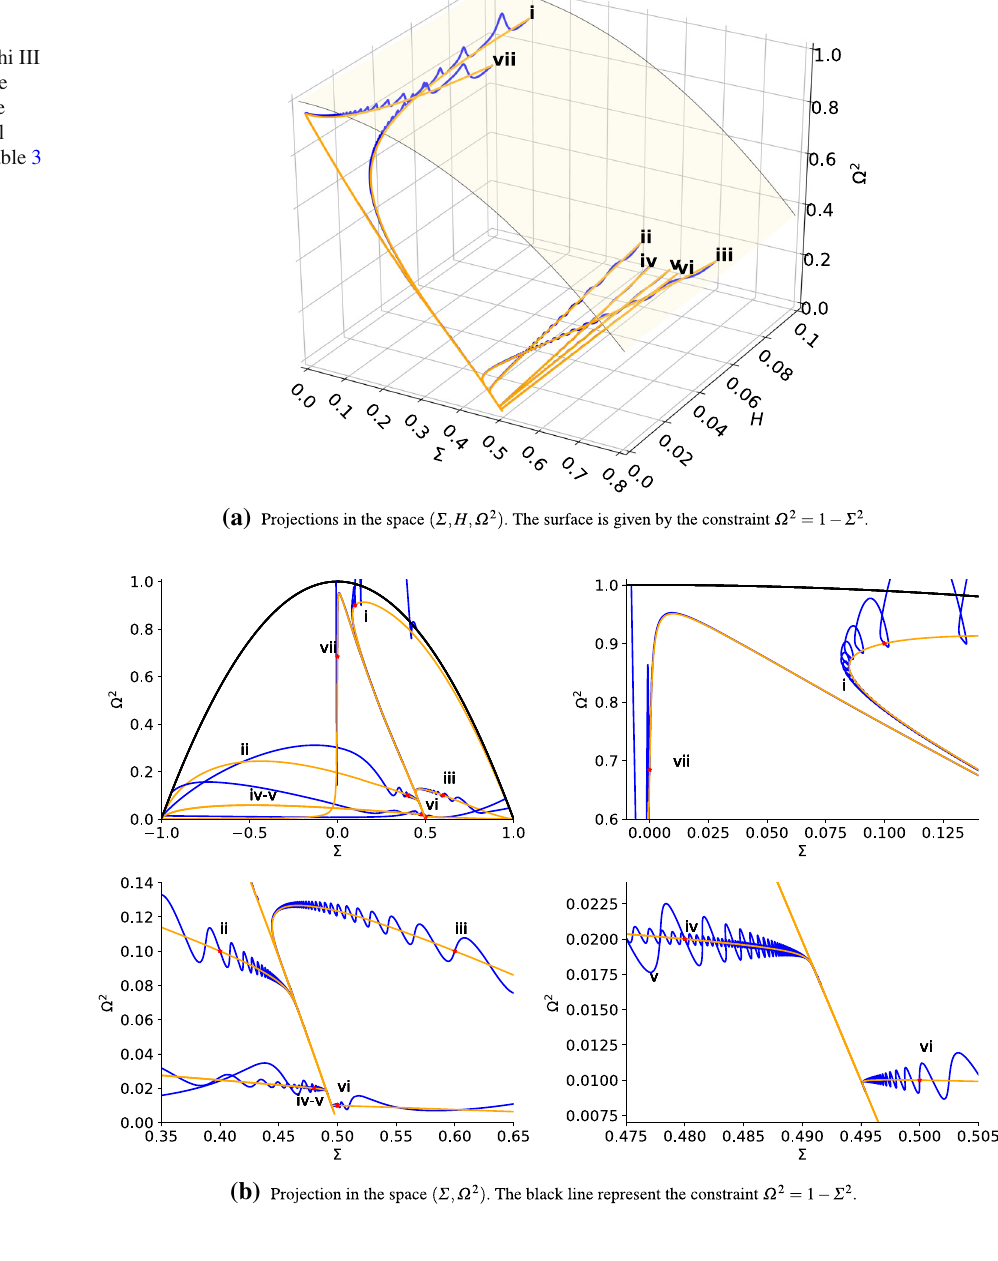
Fig. 17 Some solutions of the full system (46) (blue) and time-averaged system (78) (orange) for the LRS Bianchi III metric when γ = 4 / 3, in the projection Ω k = 0. We have used for both systems initial data sets presented in the Table